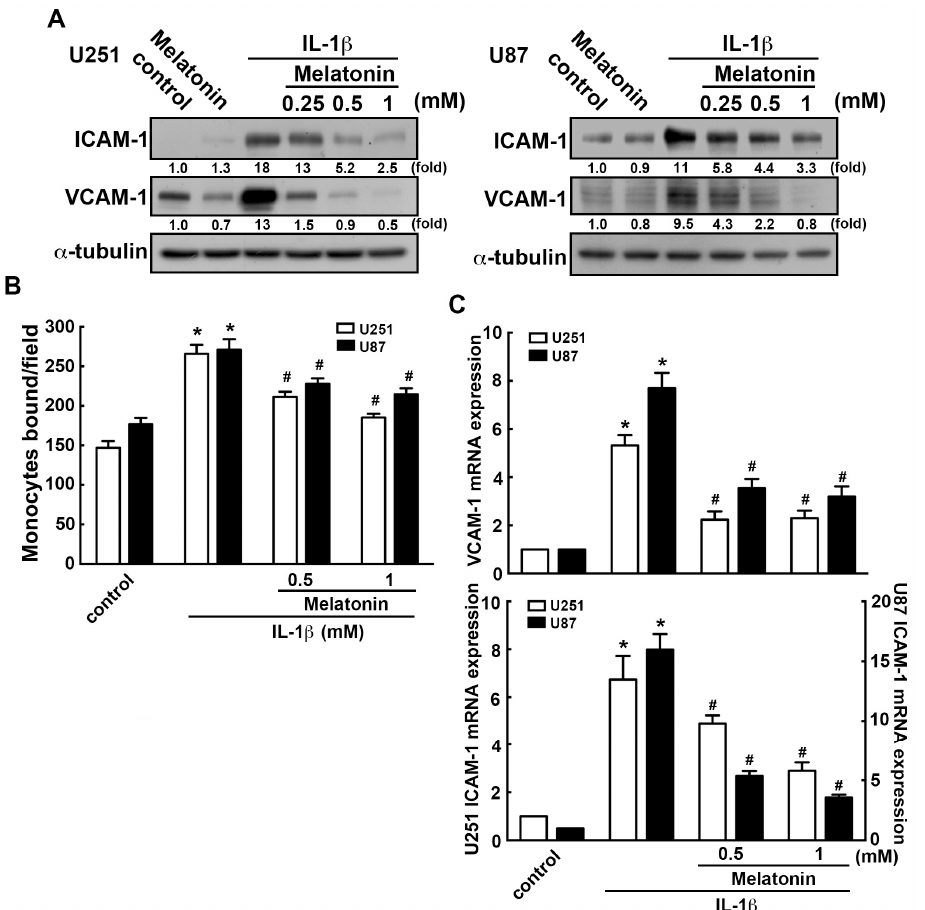
Figure 3. Melatonin attenuates IL-1 β -induced ICAM-1 and VCAM-1 expression in GBM. U251 and U87 cells were pretreated with various concentration of melatonin (0.25, 0.5 or 1 mM) for 45 min, then added to IL-1 β (3 ng / mL) for another 24 h ( A ), or 6 h ( C ). ICAM-1 and VCAM-1 expression were analyzed by western blotting ( A ) and real-time PCR ( C ), respectively. ( B ) U251 and U87 cells were pretreated with melatonin (0.5 or 1 mM) for 45 min then added with IL-1 β (3 ng/mL) for another 24 h. The binding activity of monocyte were analyzed by evaluating the BCECF-AM-labeled-THP-1 monocytes by the fluorescence microscopy. The data are presented as mean ± S.E.M. (representative of independent experiments = 3). * p < 0.05 compared with the control group. # p < 0.05 compared with the IL-1 β treatment